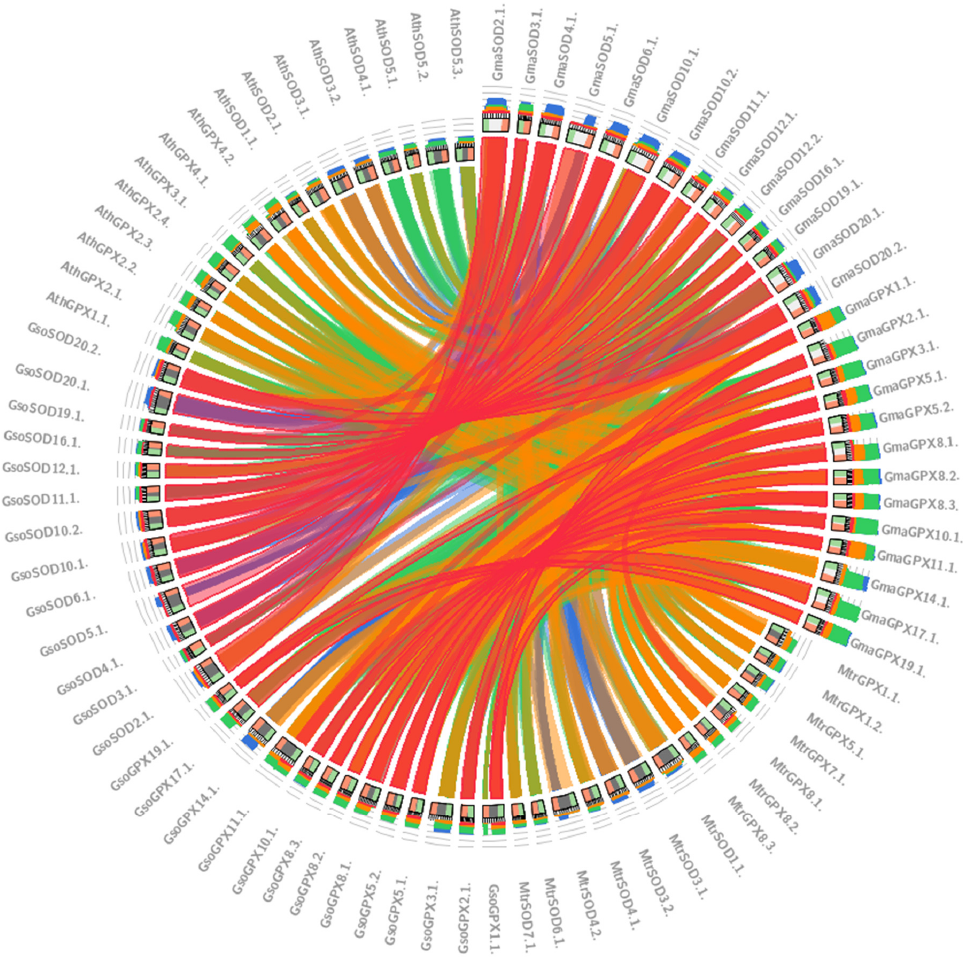
Figure 8. The synteny relationship between SOD and GPX gene families in A. thialana , G. max , G. soja and M. truncatula by using Circos tool. The blue, green, orange and red colors represent ≤ 50%, ≤ 70%, ≤ 90% and >90% identity, respectively.